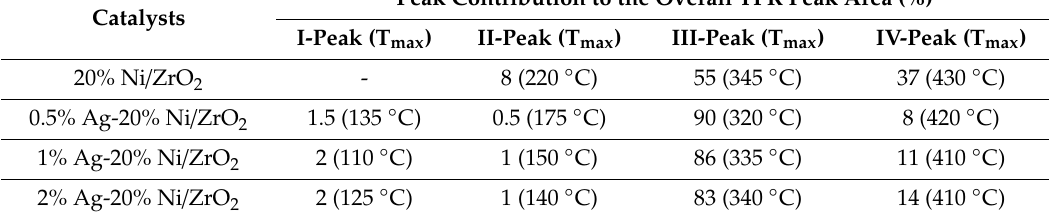
Table 7. Reduction data for the monometallic Ni and bimetallic Ag-Ni catalysts after calcination in air for 4 h at 400 ◦